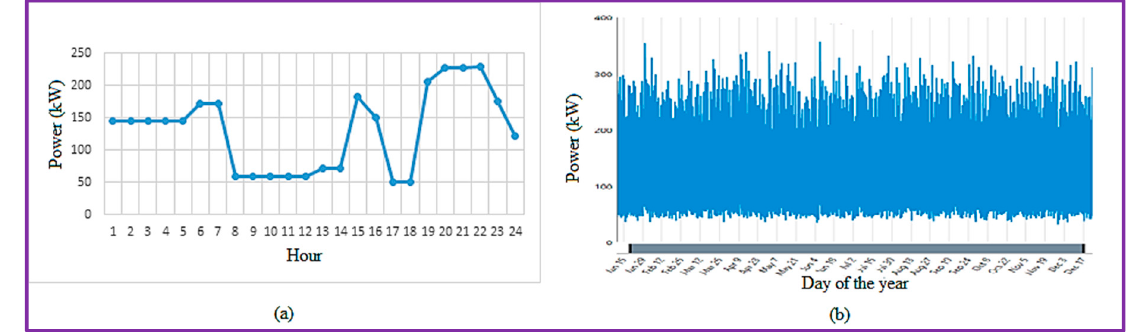
Figure 3. Load profile of Mboke village. ( a ) Hourly load profile; ( b ) Yearly load profile.